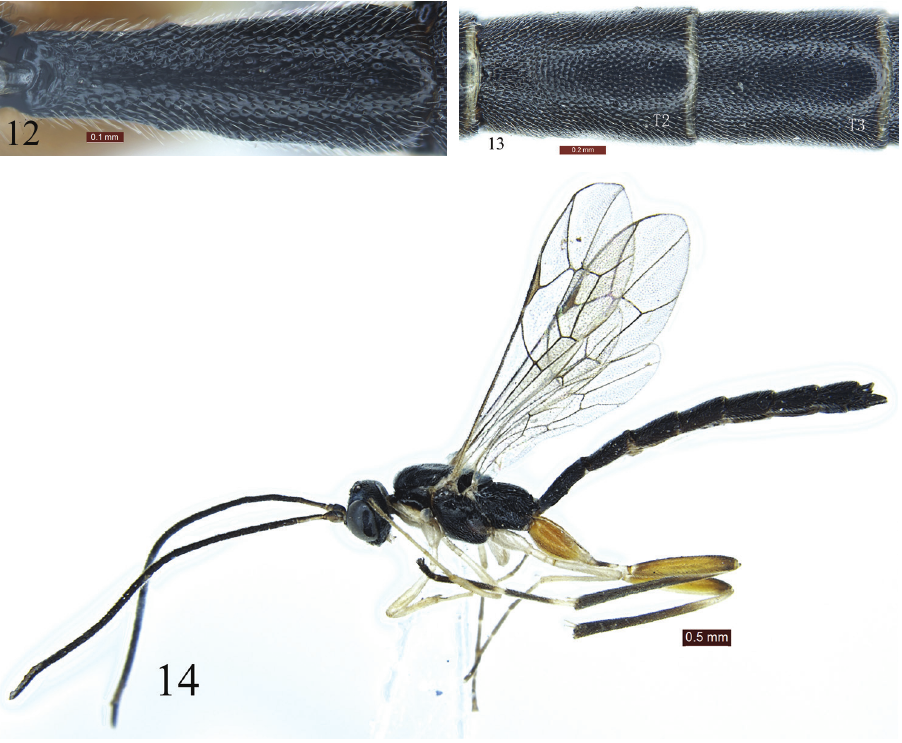
Figures 12–14. Poemenia quercusia Sun & Sheng, sp. n. Holotype. Female. 12 First tergite, dorsal view 13 Tergites 2 and 3, dorsal view 14 Paratype, male, habitus, lateral view. cal, approximately 0.3 times as long as cu-a; cu-a strongly reclivous. Ratio of length of hind tarsomeres 1:2:3:4:5 is 10.0:4.0:2.6:1.7:2.0. Propodeum (Fig. 11) evenly longi- tudinally convex, without carinae, with dense opalescent hairs; apical-median portion with indistinct transverse rugae. Propodeal spiracle circular. Metasoma . First tergite (Figs 6, 12) approximately 2.7 times as long as apical width, 1.3 times as long as second tergite (Fig. 13), subcylindrical; with dense indistinct